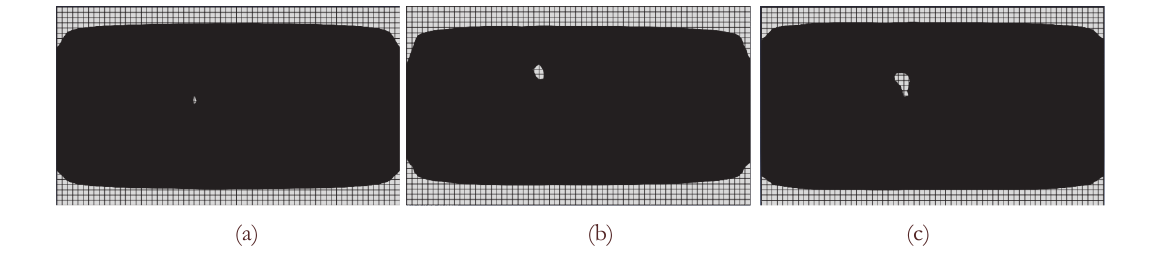
Figure 4: Damaged zone for a rectangular patch (a) θ = 15 o , (b) θ = 45 o and (c) θ = 75 o .